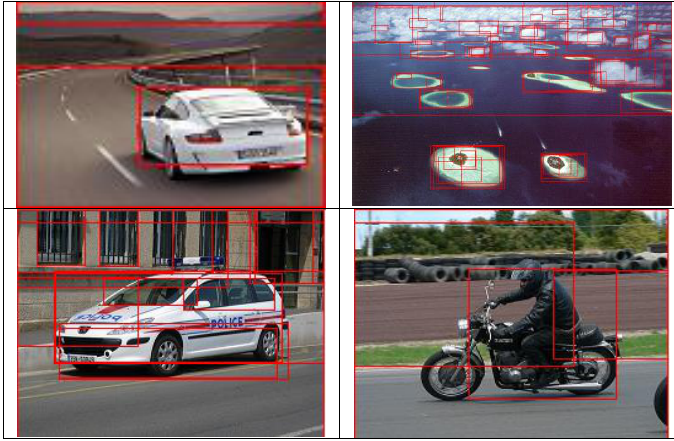
Figure 1. Using the tree of morphlets approach for objects detection in images